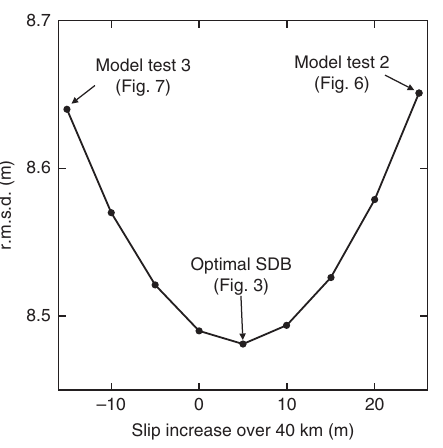
Figure 5 | Sensitivity of SDB to slip gradient for the central corridor in terms of increase over the most near-trench 40km. Trenchward increase (as in Fig. 3a) is positive. Average slip is fixed at the optimal value of 62m; the optimal depth adjustment varies with the slip gradient (not displayed).